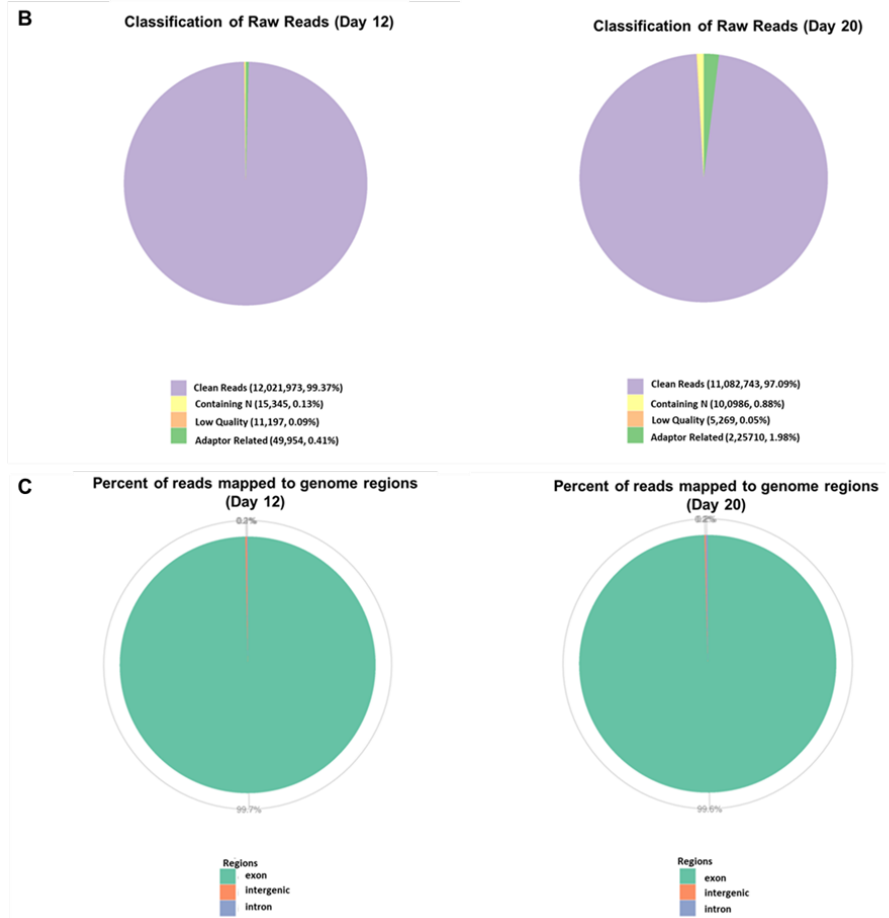
Figure 4. The flowchart for methodology for identification of U-to-C RNA editing site. ( A ) Raw reads are filtered to remove reads containing adapters or reads of low quality, so that downstream analyses are based on clean reads. The filtering process is as follows. (1) Discard reads with adaptor contamination. (2) Discard reads when uncertain nucleotides constitute more than 10% of either read (N > 10%). (3) Discard reads when low-quality nucleotides (base quality less than 20) constitute more than 50% of the read. For mapping sequences, TopHat2 was chosen for plant genomes. The mismatch parameter was set to 2 and other parameters were set to default. Appropriate parameters were also set, such as the longest intron length. Only filtered reads were used to analyze the mapping status of RNA-seq data to the reference genome. Edited sites were further validated and confirmed by RT-PCR. ( B ) Clean reads for day 12 and day 20. ( C ) Percentage of reads mapped to genome regions for day 12 and day 20. Table 2. List of genes identified with U-to-C RNA editing sites in 12-day- and 20-day-old Arabidopsis seedlings.